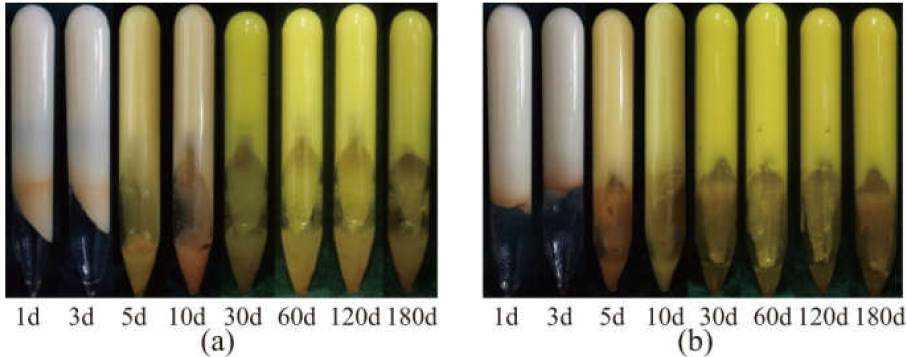
Figure 11. Aging status of gels with different compositions at 110 ◦ C for different times: ( a ) gel prepared with 0.4 wt% HPAM, 0.4 wt% WSPR, and 1.0 wt% nano-SiO 2 ; ( b ) Gel prepared with 1.0 wt% HPAM, 1.0 wt% WSPR, and 1.0 wt% nano-SiO 2